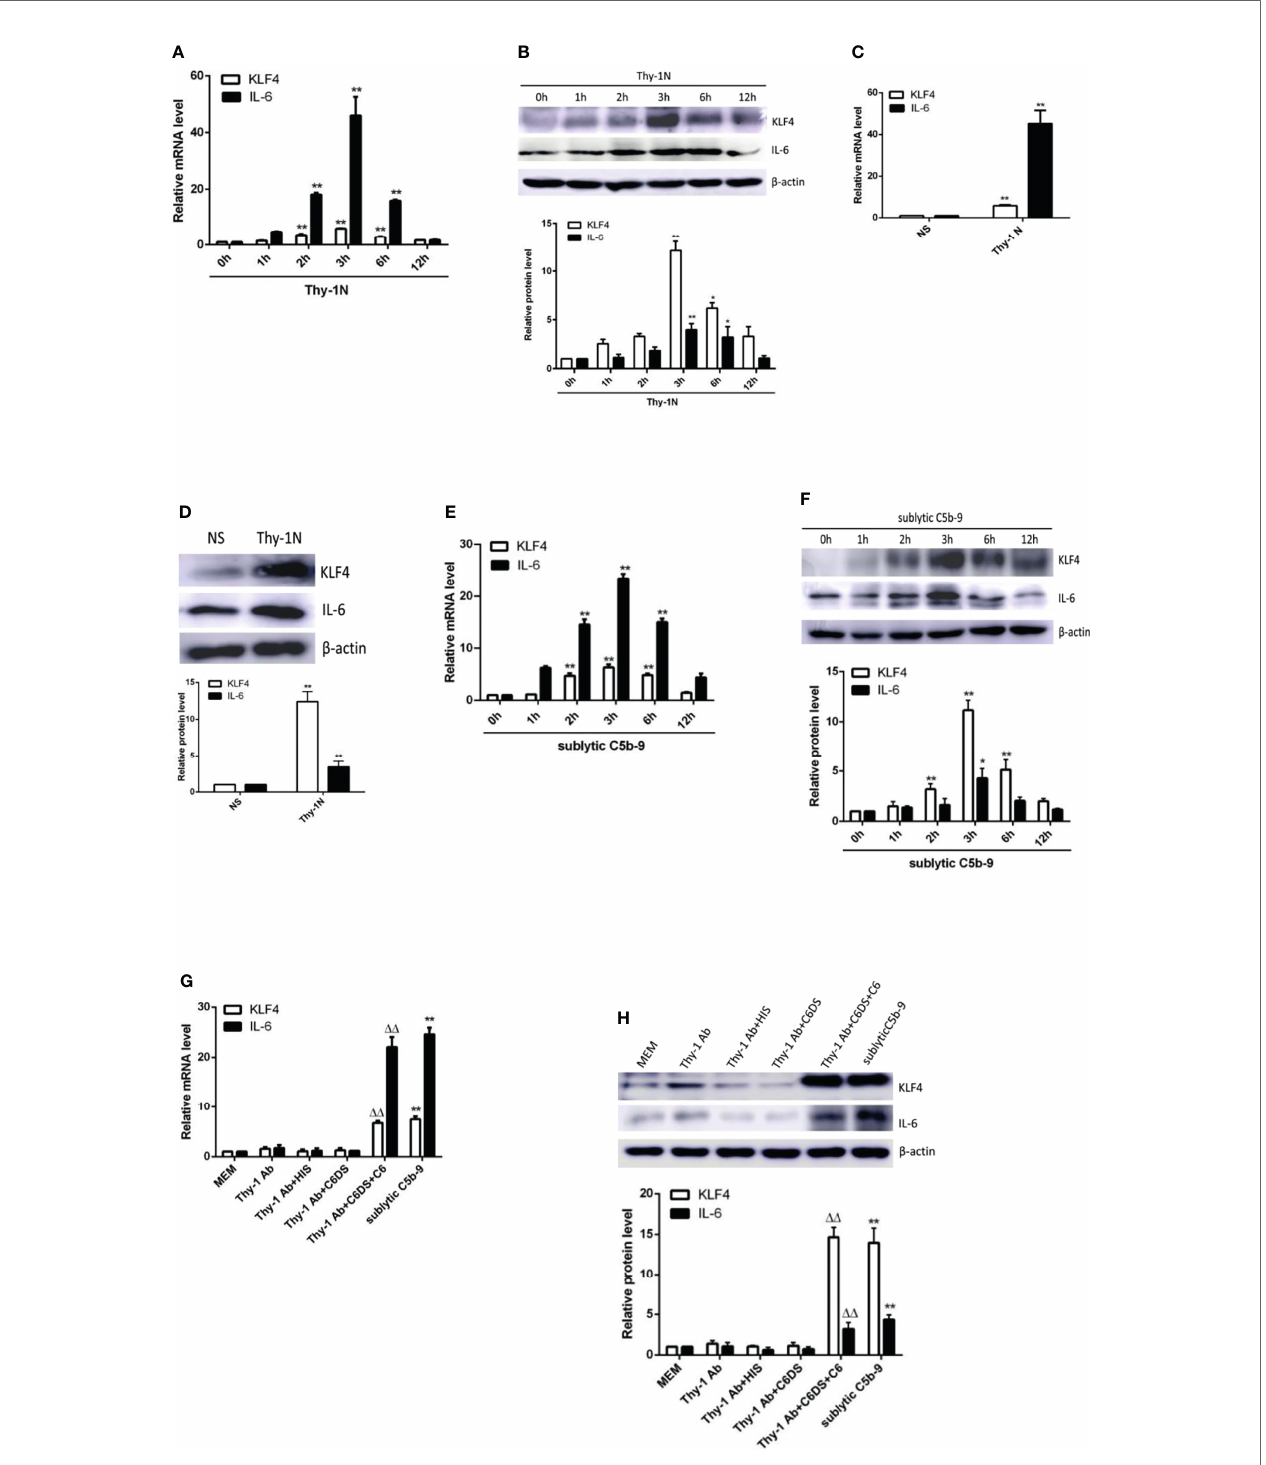
FIGURE 1 | Expression of KLF4 and IL-6 both in renal tissue of Thy-1N rats and in GMCs stimulated by sublytic C5b-9. (A , B) qPCR and IB analyses of KLF4 and IL-6 in renal cortex of Thy-1N rats at indicated times (*p < 0.05, **p < 0.01 vs. 0 h). (C , D) qPCR and IB analyses of KLF4 and IL-6 in renal cortex of Thy-1N and NS rats for 3 h (**p < 0.01 vs. NS). (E , F) qPCR and IB analyses of KLF4 and IL-6 in GMCs treated with sublytic C5b-9 at indicated times (*p < 0.05, **p < 0.01 vs. 0 h). (G , H) qPCR and IB analyses of KLF4 and IL-6 in GMCs with different treatments for 3 h (**p < 0.01 vs. Thy-1 Ab, Thy-1 Ab + HIS, Thy-1 Ab + C6DS, and MEM; DD p < 0.01 vs. Thy-1 Ab + C6DS). Data are representative of three independent experiments with similar results or are shown as mean ± SD from three independent experiments. Thy-1N, Thy-1 nephritis; GMCs, glomerular mesangial cells; IB, immunoblotting; NS, normal rabbit serum; MEM, minimum essential